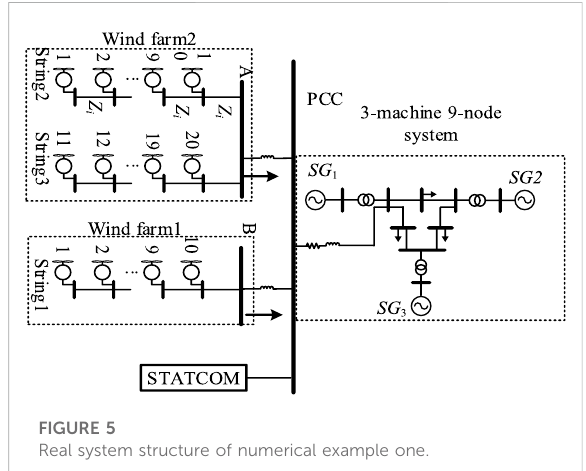
FIGURE 5 Real system structure of numerical example